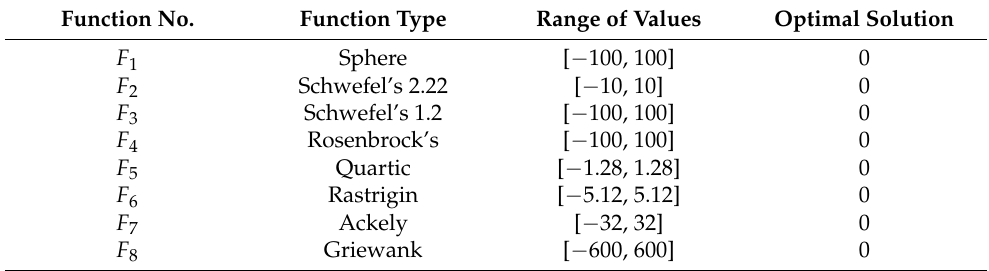
Table 1. Benchmark function.